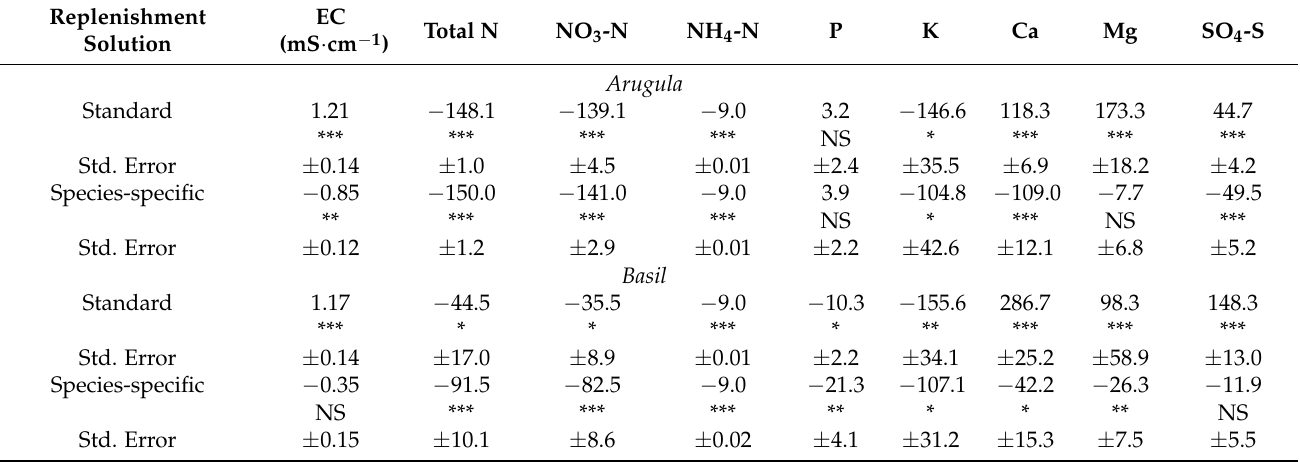
Table 5. Change in solution electrical conductivity (EC) and concentrations (in mg · L − 1 ) of total nitrogen (N), nitrate nitrogen (NO 3 -N), ammonium nitrogen (NH 4 -N), phosphorus (P), potassium (K), calcium (Ca), magnesium (Mg), and sulfate-sulfur (SO 4 -S) from initial concentrations in the standard hydroponic solution at 21 d for arugula and basil replenished with standard and species- specific replenishment solutions. Positive and negative values represent an increase or decrease, respectively, in EC or